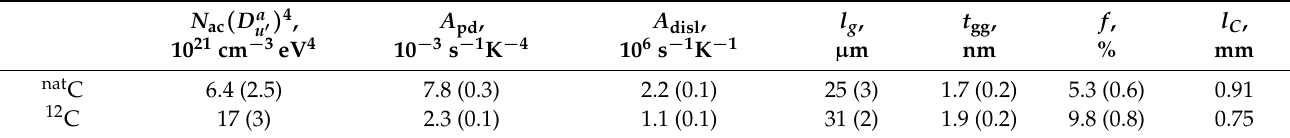
Table 1. Parameters of the model that yield the best fit to the experimental data for chemical vapor deposition (CVD) diamond samples. The standard error, including the systematic one, is indicated in parentheses. N ac is the concentration of acceptors in 1 cm 3 .